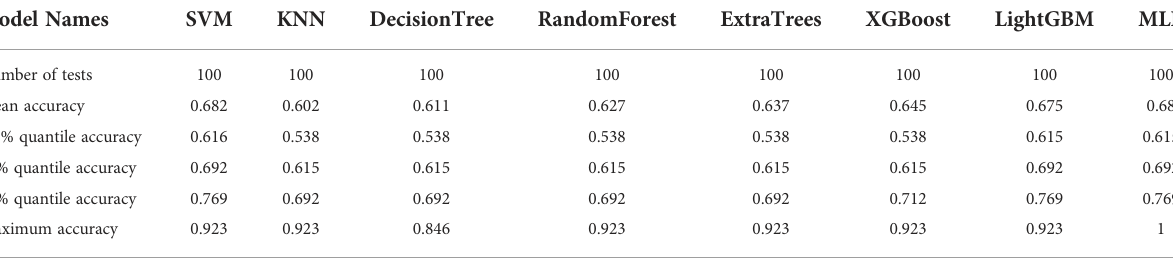
TABLE 9 Distribution of the accuracy of each model randomly tested 100 times by eight common machine learning algorithms. Model